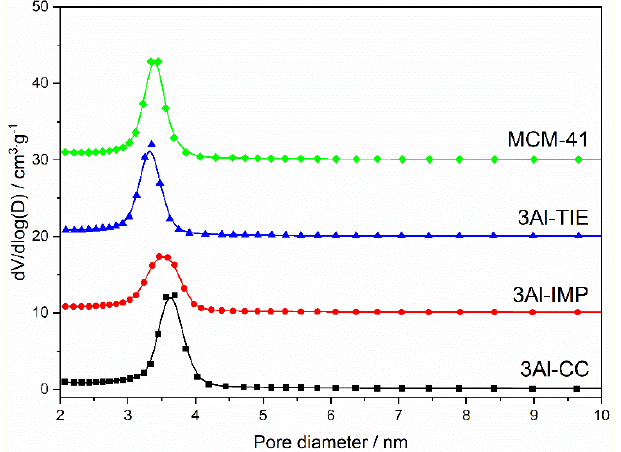
Figure 3. Pore size distribution (PSD) determined for MCM-41, modified with aluminum by different methods, and for pure silica